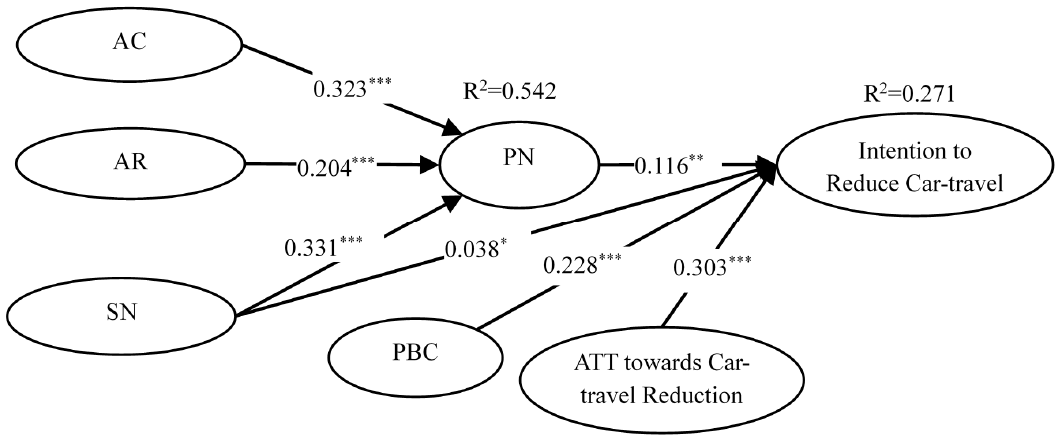
Figure 2. Standardized Path Coefficients of the Model. Notes: AC = Awareness of consequence of car-travel; AR = Ascription of responsibility for car-travel reduction; PN= Personal norm of car-travel reduction; SN = Subjective norm of car-travel reduction; PBC = PBC over car-travel reduction. * p < 0.05; ** p < 0.01; *** p < 0.001.